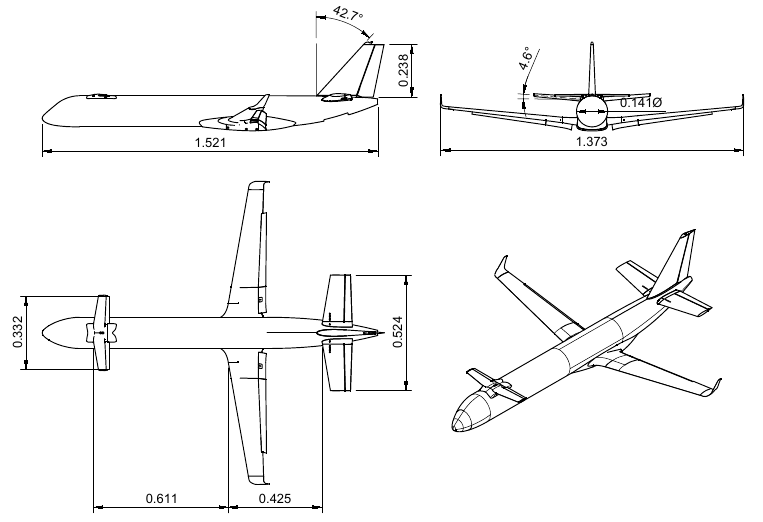
Figure 2. Scaled aircraft model at the end of design loop 2. Units in